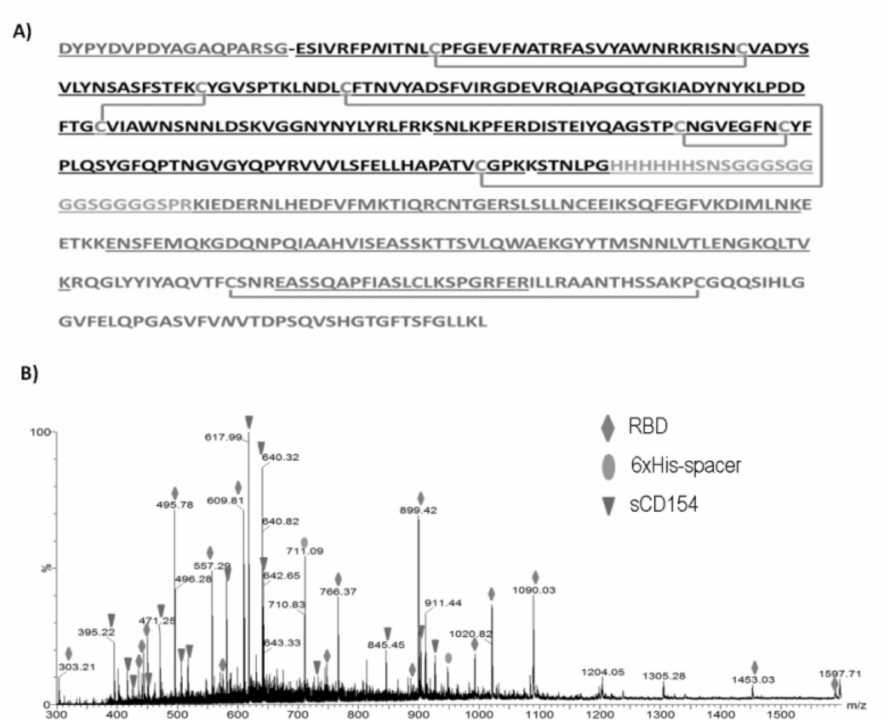
Figure 4. RBD-CD ESI-MS characterization ( A ) Amino acid sequence of the RBD-CD recombinant protein. The verified sequence by ESI-MS/MS analysis is underlined. The first residues correspond to additional 18 amino acids from the pDisplay subcloning vector. In black the receptor-binding domain (RBD) of SARS-CoV-2 S protein (residues Glu324-Gly535). The lines represent disulfide bonds that link C336-C361, C379-C432, C480-C488, and C391-C525 (for RBD) and C178-C218 for CD154. Residues indicated as N correspond to potential N-glycosylation sites. ( B ) ESI-MS spectrum of tryptic digestion of the RBD-CD protein in a buffer-free solution. The signals marked with diamonds correspond to the RBD protein peptides, the triangles to the CD154 fragment, and the ovals to the six His tails plus the spacer